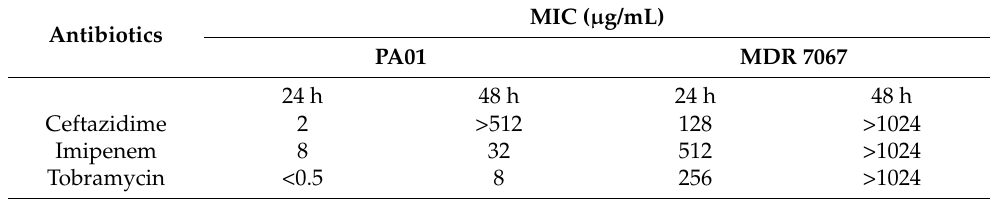
Table 1. The MICs of three antibiotics against PA01 and MDR 7067 bacterial strains of P. aeruginosa .